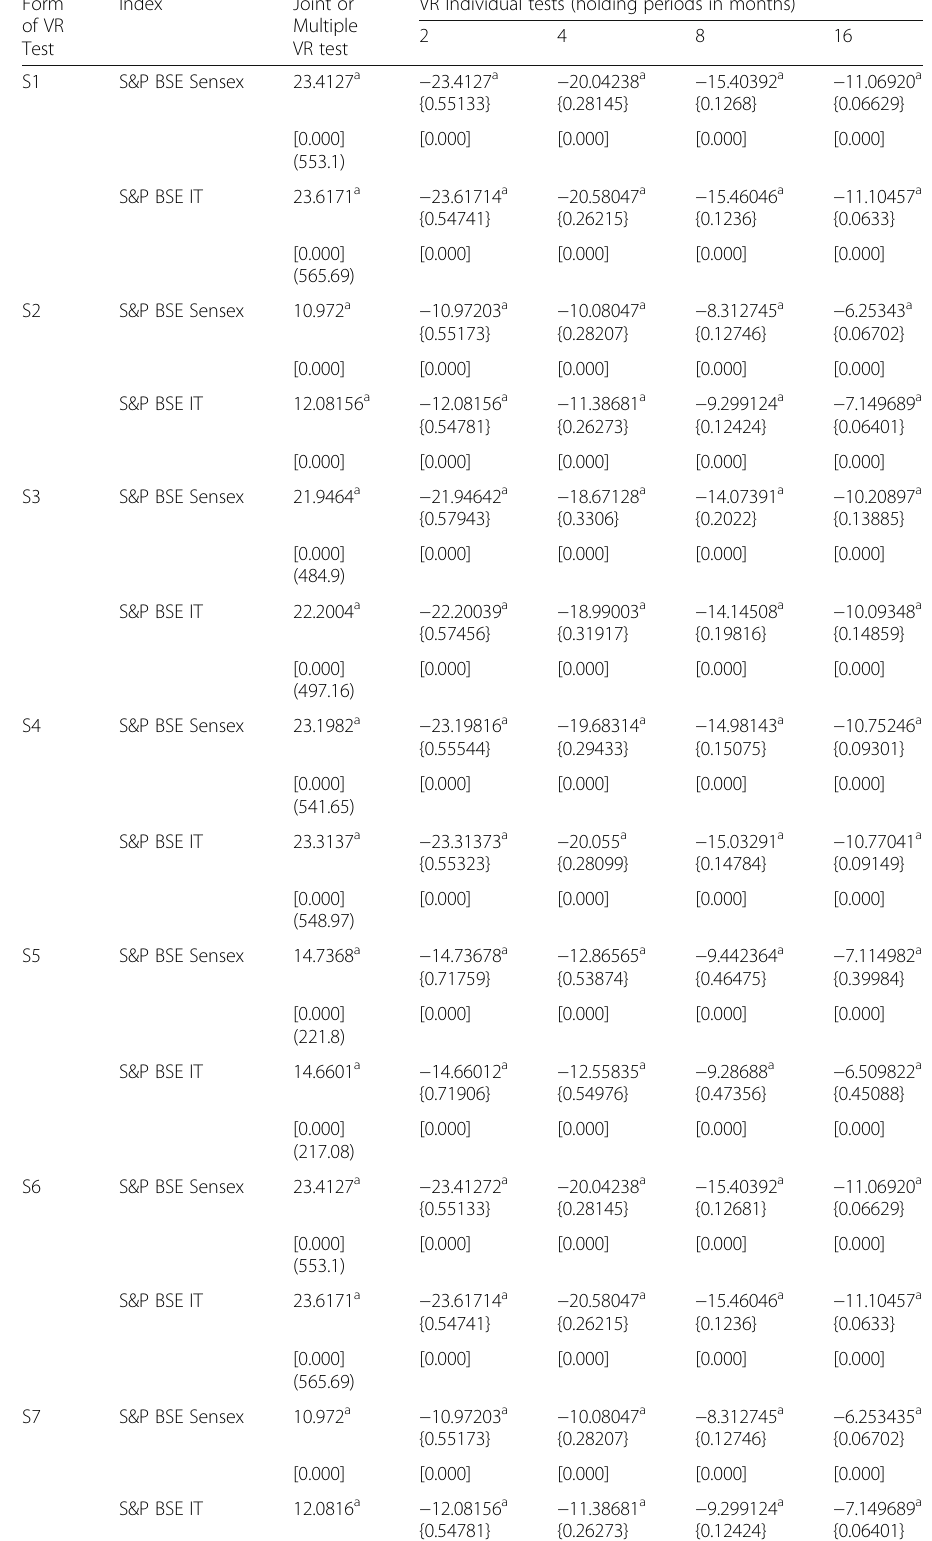
Table 2 Multiple and individual VR tests for return